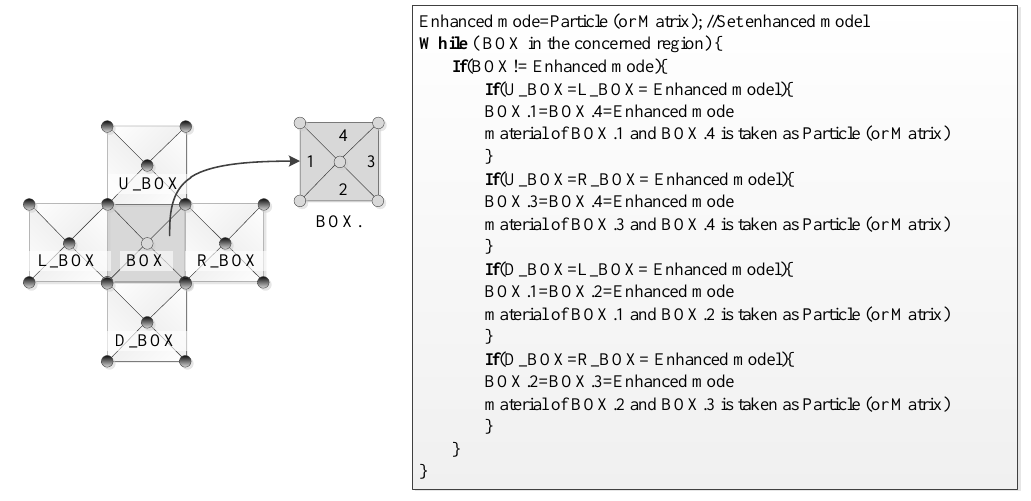
Figure 4. Schematic and pseudocode of the smoothing algorithm.